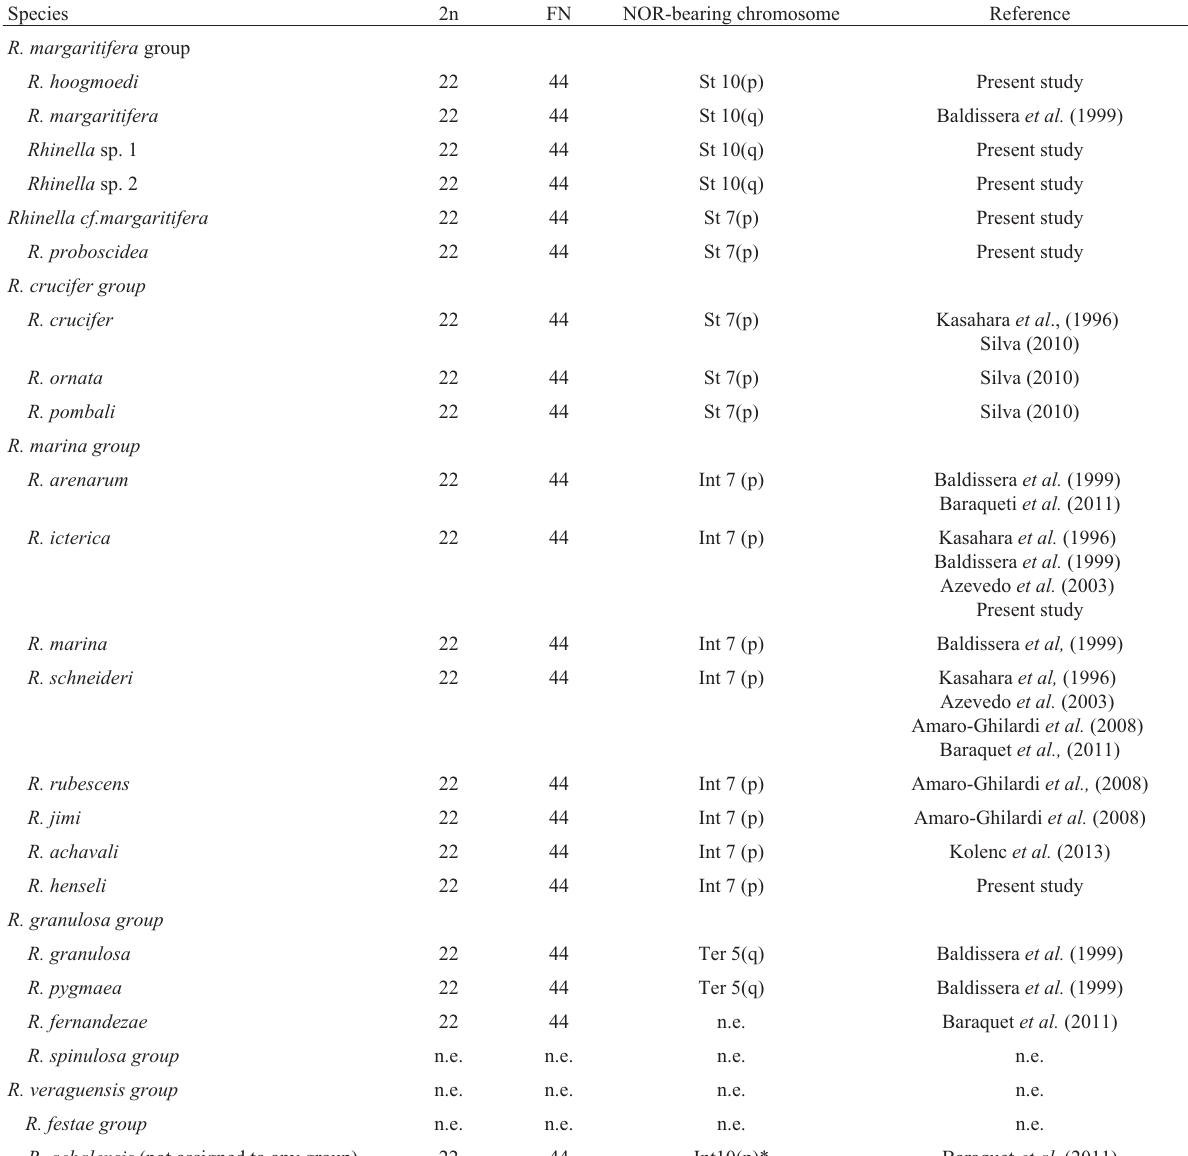
Table 2 - Detailed cytogenetic data available for species of the Rhinella